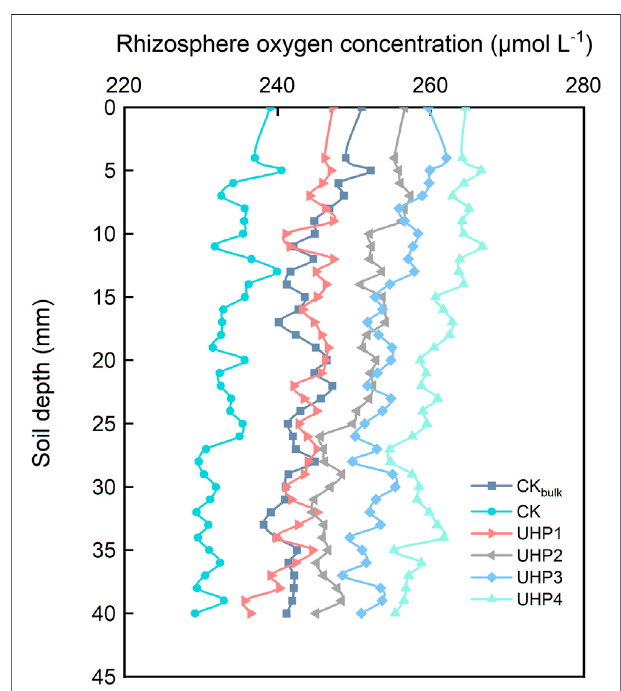
FIGURE 1 | Representative graph showing the O 2 pro fi les of the rhizosphere soil (4 cm away from the root surface) harvested at 25 ° C. CK bulk represents no UHP application and no amaranth growth; CK represents no UHP application. 3 mm from the soil surface was de fi ned as “ 0 ” point. The O 2 pro fi les obtained in each replication of the same treatment were generally similar, and results of triple averaging are shown.